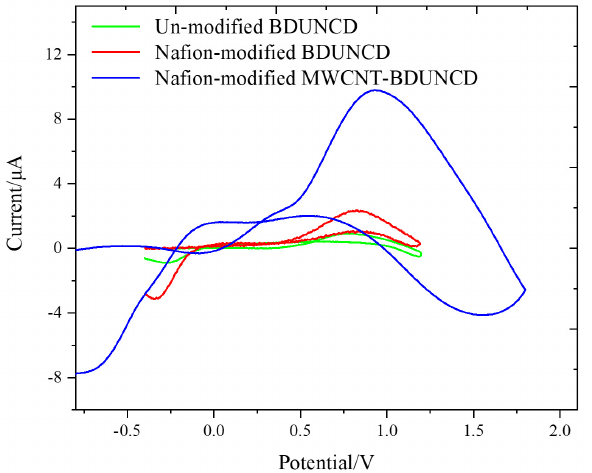
Figure 3. Fast-scan cyclic voltammograms of surface-modified BDUNCD microelectrodes. The green color represents the unmodified BDUNCD microelectrode, the red color represents the nafion-modified BDUNCD microelectrode (red), and the blue color represents the nafion–MWCNT-modified BDUNCD microelectrode. Voltammograms were taken in 100 μ M dopamine (DA) and 1X PBS buffer at 400 V/s and undertook background subtraction. The flow rate was 0.2 mL/min. Table 1. Comparison of 100 μ M DA peak oxidation and reduction currents and potentials of the cyclic voltammograms from the three types of BDUCND microelectrodes (unmodified, nafion-mod- ified, and nafion–MWCNT-modified BDUCND) ( n = 3). CV parameters